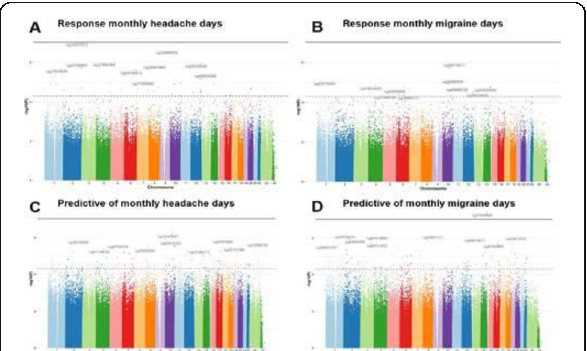
Fig. 1 (abstract A21). Manhattan plots from the epigenome-wide association study. Manhattan plot showing the -log10 p value for each CpG site. The threshold for genome wide significance (p <9.42 x 10 -1 ) is indicated by a continues line. The threshold for suggestive genome wide significance (p < 5 x 10 -1 ) is indicated by a striped line. Changes in DNA methylation in monthly headache days